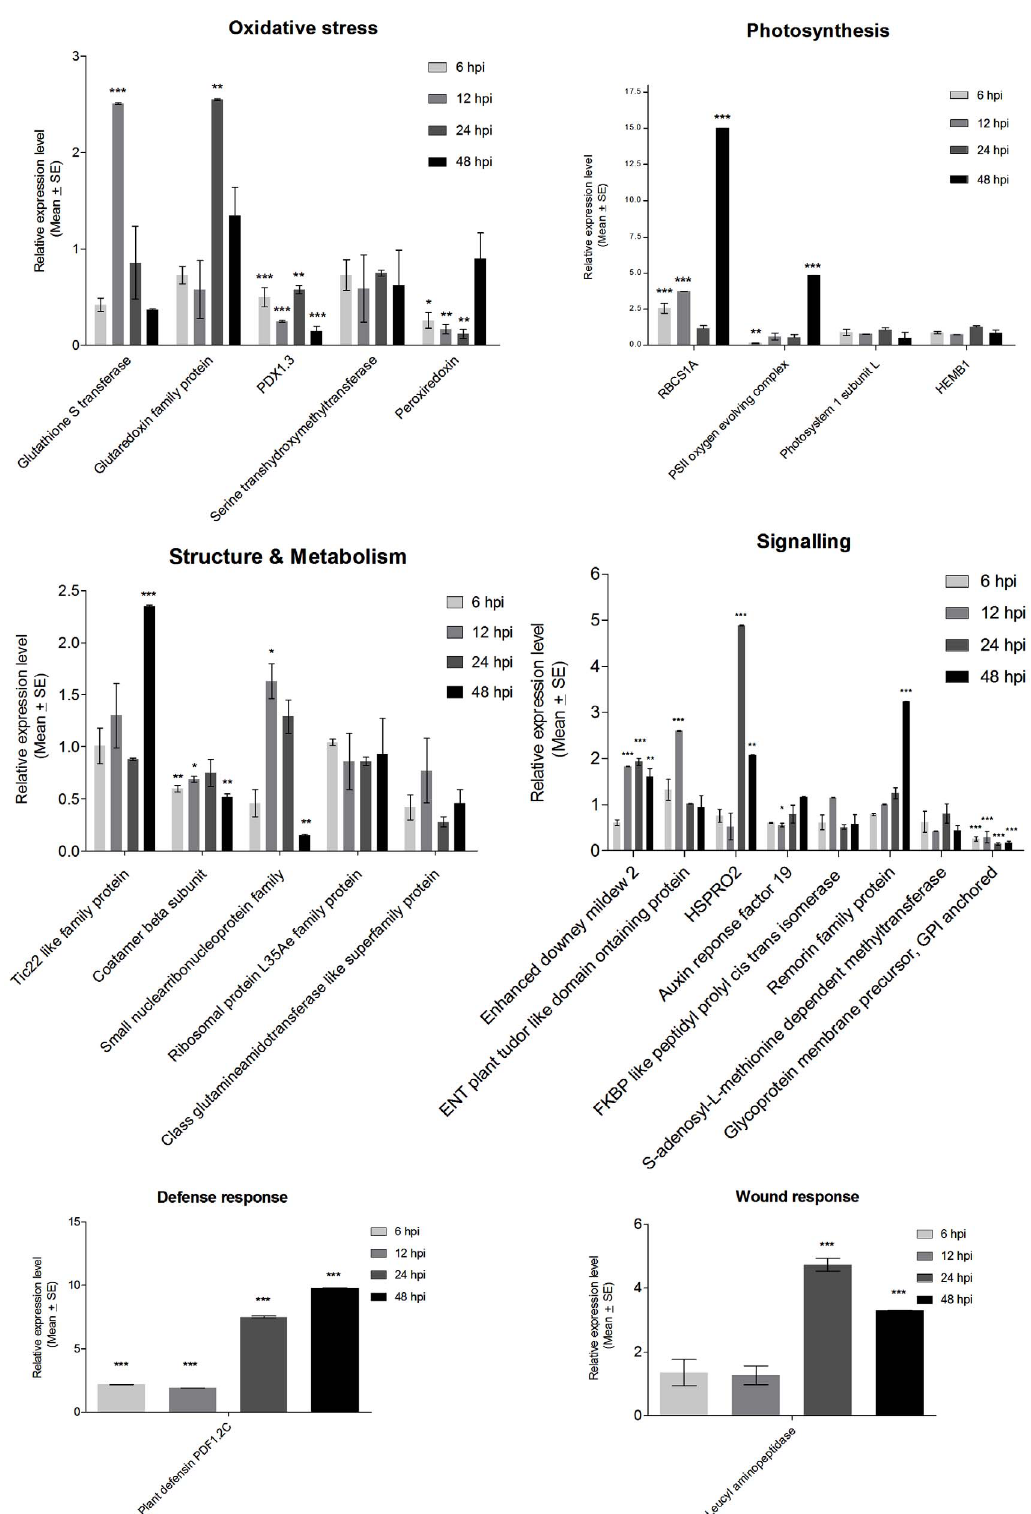
Figure 3. Time course relative gene expression analysis. Time course relative expression (Y-axis) level profiles of 24 genes induced in R. indica on forced infestation with L. erysimi (as identified by cDNA AFLP with respect to uninfested plants) at different time points viz. 6, 12, 24, 48 hours post infestation (X-axis), as analysed quantitative real time RT PCR analysis. The genes have been represented under different functional categories. Error bars represent standard error of the mean (n=3). ‘*’, ‘**’ and ‘***’ indicate the level of significance of the relative gene expression level noted at the significance level of p , 0.05.